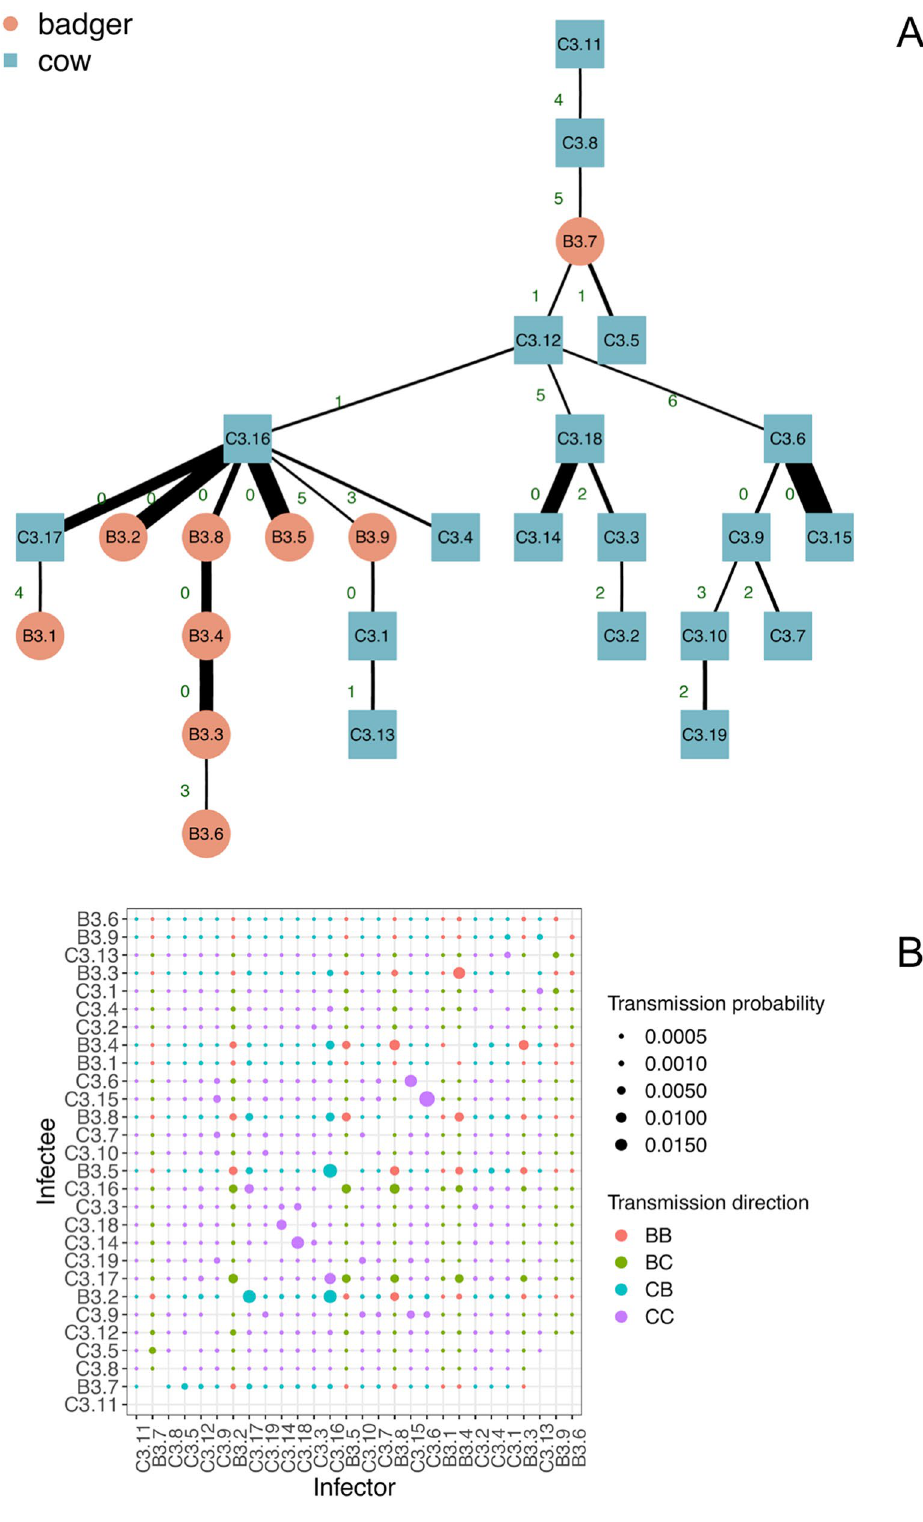
Figure 5. Transmission tree with alternative pathogen bottleneck model. Transmission tree ( A , top to bottom) and transmission probability matrix ( B ) for clade 3, assuming an alternative model where SNPs substitution is allowed during the infectious period only (see Fig. 3 caption for full